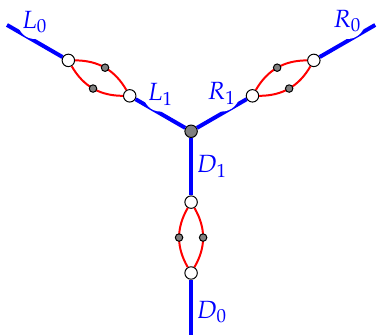
Figure 2. The reduction from the nondeterministic constraint logic problem to the problem Π . White points denote the vertices of A , and gray points denote the vertices of B . Thick (blue) lines denote the edges with weight 2, and thin (red) lines denote the edges with weight 1.